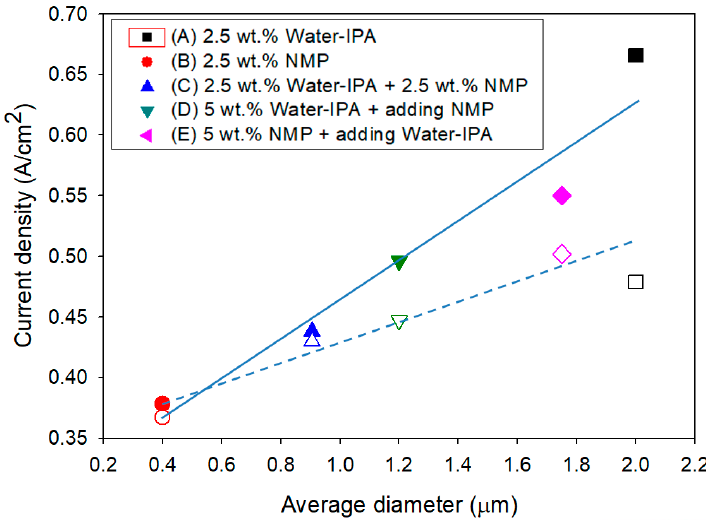
Figure 6. Current density of the MEAs at 0.6 V as function of the average size of ionomers in five different dispersions (the solid and blank symbols represent the maximum current densities during potential cycles and the current densities at the 30kth potential cycle, respectively; and the R 2 and p -value of the regressed solid line and the regressed dotted line are 0.97 and 0.007 and 0.80 and 0.04, respectively).